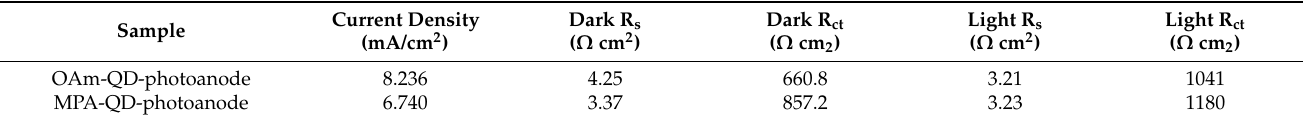
Table 1. Summary of J – V characteristics and impedance analysis for TiO 2 —QDs photoanodes.